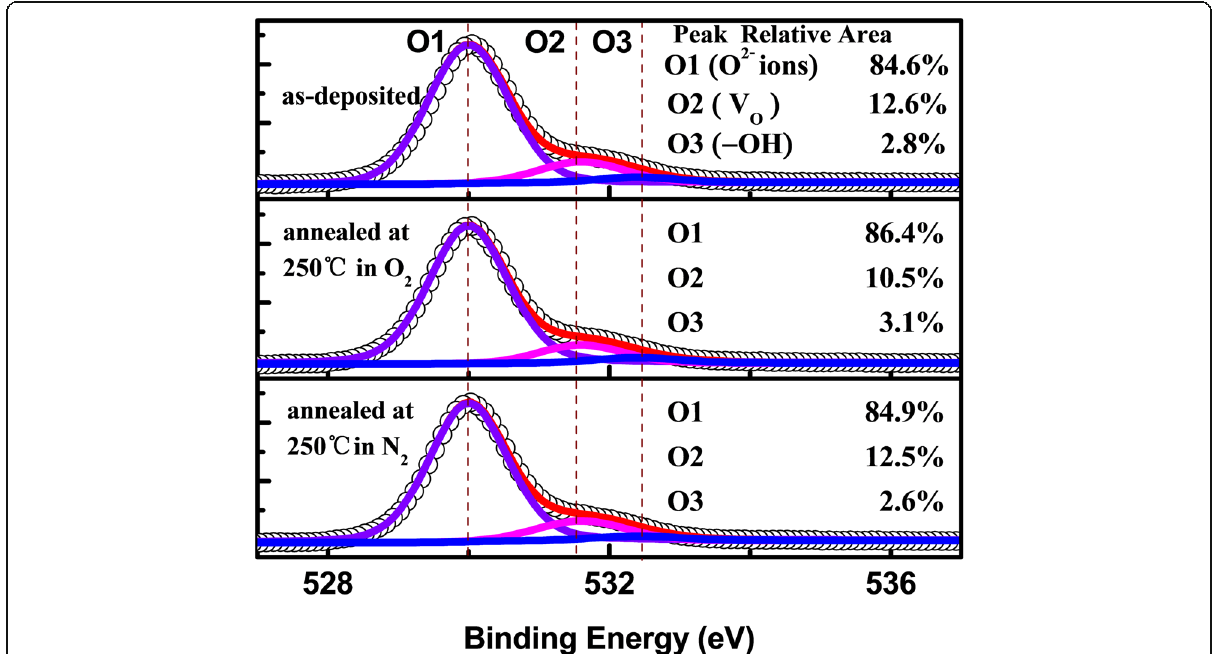
Fig. 7 High-resolution O1s XPS spectra of the as-deposited ZnO film and those annealed at 250 °C in O 2 and N 2 , respectively. O1 and O2 correspond to O 2 − ions bound with Zn 2+ and oxygen vacancies, respectively. O3 is attributed to chemisorbed oxygen element ( – OH, etc). To remove unintentionally surface contaminants, all the samples were etched with in situ Ar ion bombardment